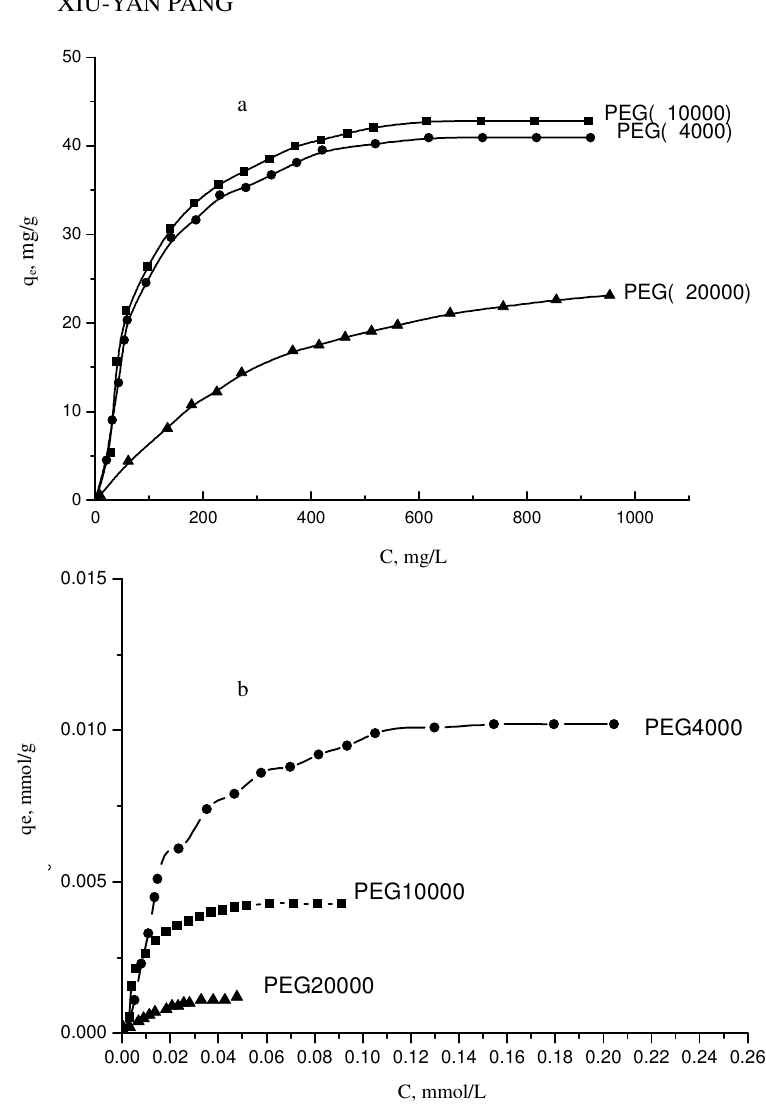
Figure 1. Adsorption isotherm of PEG (1000, 4000, 10000 and 20000) at 25 o C (a) Unit of adsorbance is defined as mg/g; (b) Unit of adsorbance is defined as mmoL/g, Langmuir equation (3) was used to treat the isotherm data. The molecule area (a) of PEG was calculated according to maximum adsorbance Q Table 1. Q - maximum adsorbance; mmoL/g A - The equilibrium concentration of PEG 0 corresponding to half saturation adsorbance;